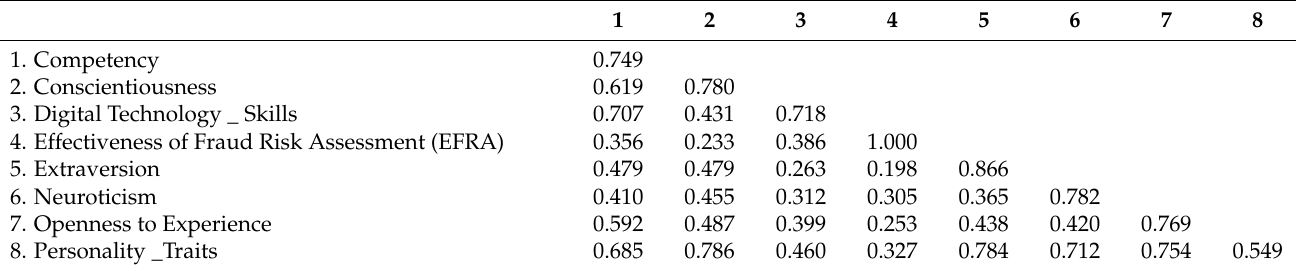
Table 5. Discriminant Validity (Fornell and Larker Criterion).